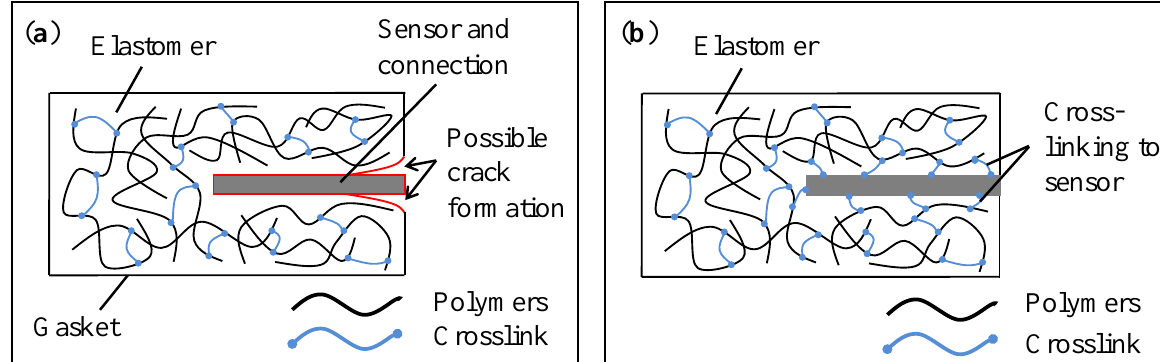
Figure 1. A sketch of an embedded sensor in a gasket ( a ) with no crosslinking agents between sensor and elastomer, which exhibits a possible source of crack formation and separation; ( b ) with crosslinking between host material and sensor